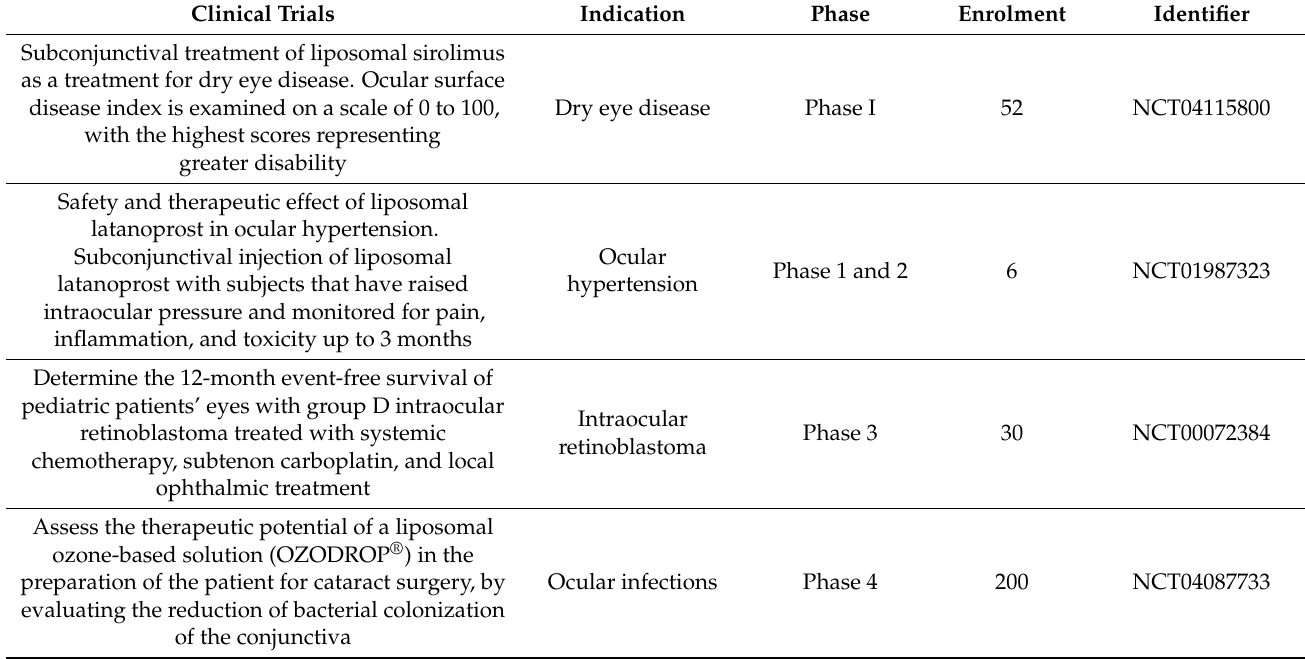
Table 7. Continuing and finished clinical trials of liposome-based formulations evaluated for ocular